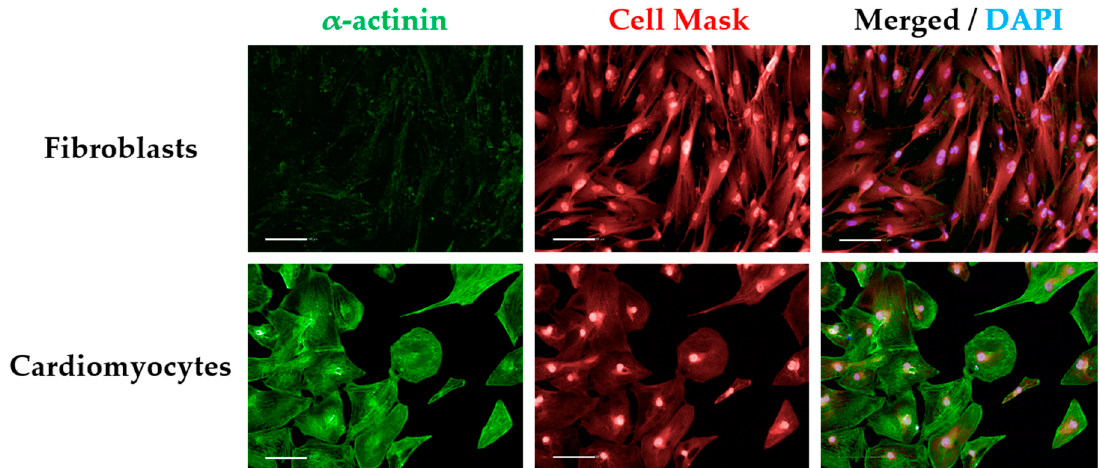
Figure A1. Cell-type control for α -actinin staining . Comparing signal intensities of α -actinin between fibroblasts or any cell type that does not express the cardiac marker (cell-type control) with cardiomyocytes enables determination of positive signal threshold required for high-content imaging. Scale bar = 100 μ m.